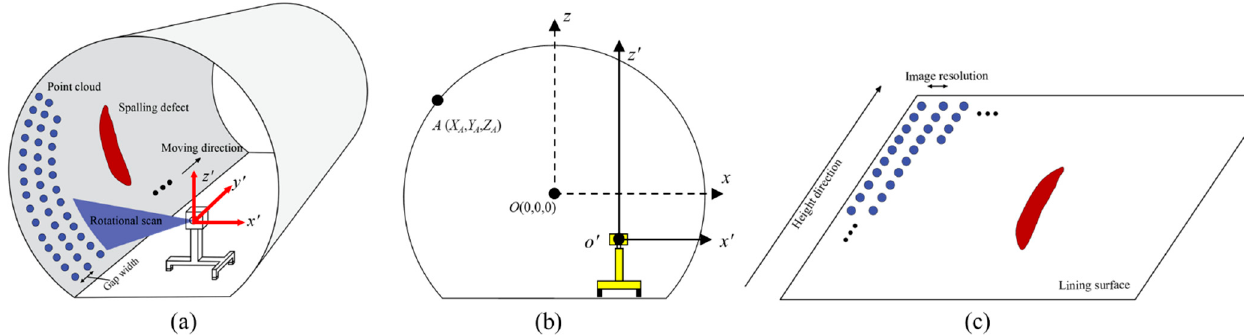
Figure 3. Schematic illustration of ( a ) the spalling defects scanning principle, ( b ) coordinates origin conversion to solve the unrolling distortion issue, and ( c ) 2D image generation based on the plane point cloud data.